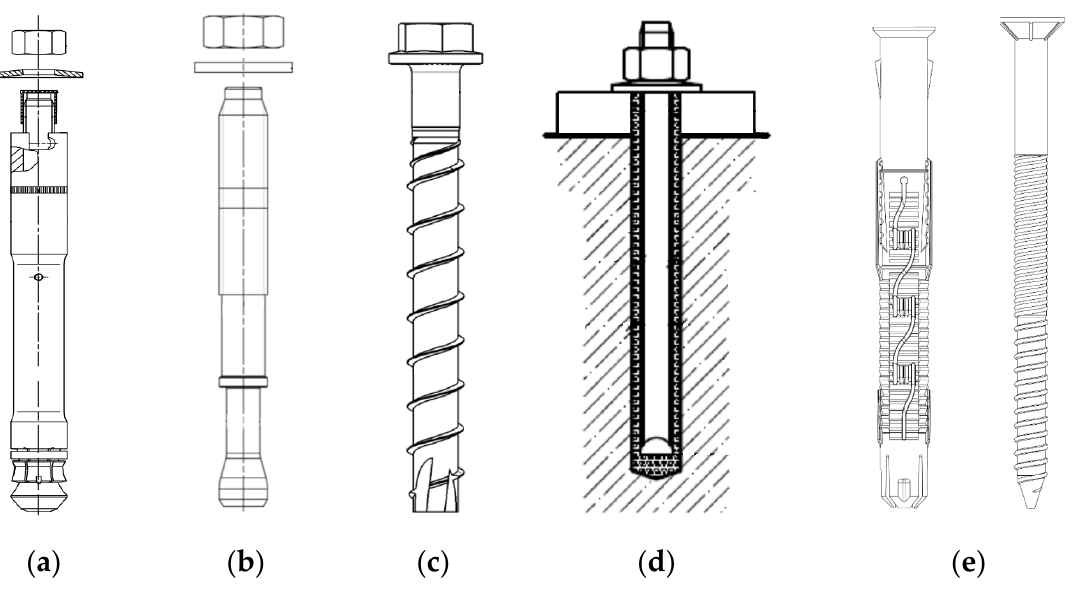
Figure 3. Post-installed anchors: ( a ) undercut anchors; ( b ) wedge expansion anchors; ( c ) screw anchors; ( d ) adhesive anchors; ( e ) plastic anchors.